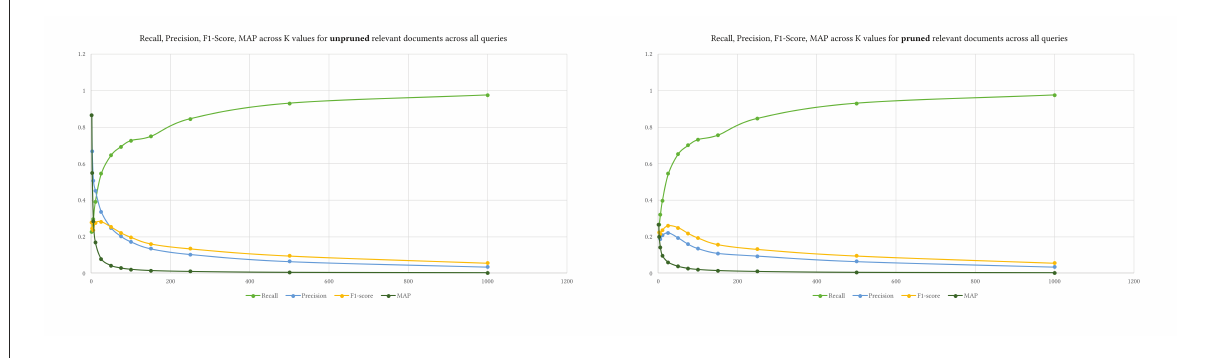
FIGURE7 The difference between pruned and unpruned retrieved results.